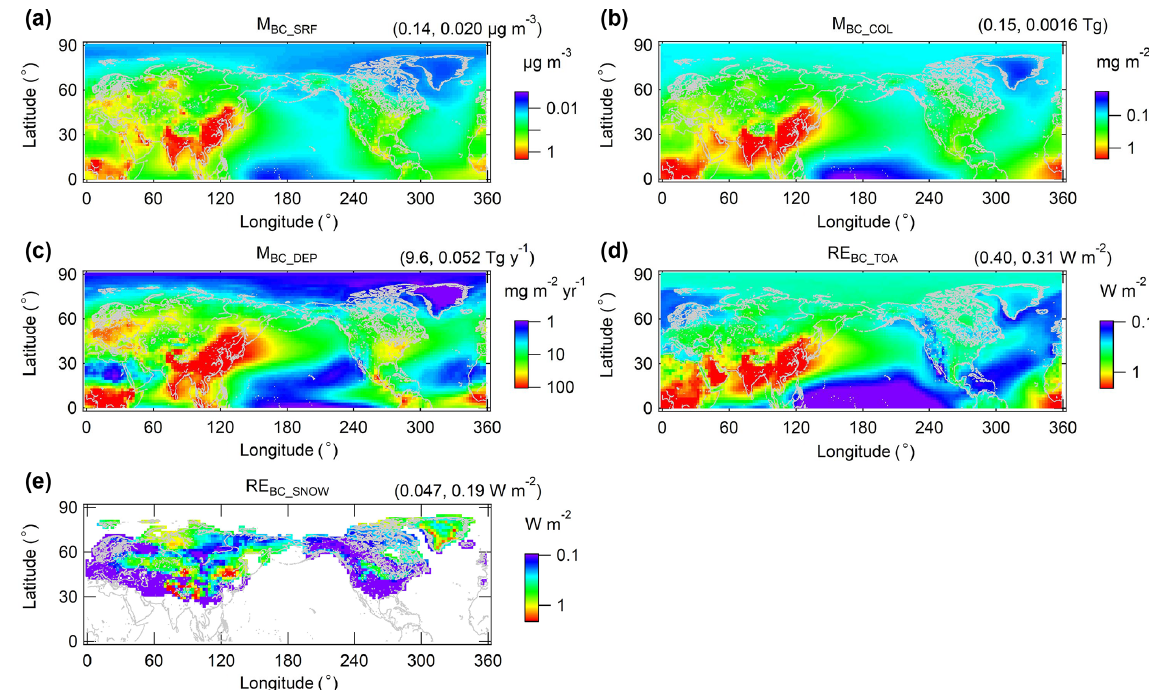
Figure 6. Spatial distributions of (a) M BC_SRF , (b) M BC_COL , (c) M BC_DEP , (d) RE BC_TOA , and (e) RE BC_SNOW in the Northern Hemi- sphere. The values in parentheses are global (left) and Arctic (right) mean values (annual mean). Purple shows areas where values are below the minimum shown on the color bars.